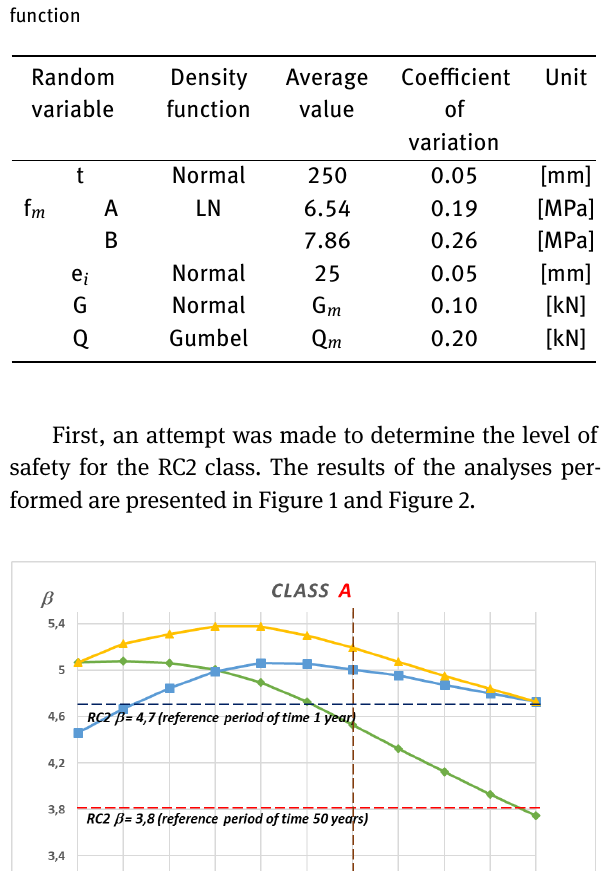
Figure 2: Reliability coeflcient curves β and load factor χ for the class B execution of works and three different combinations of